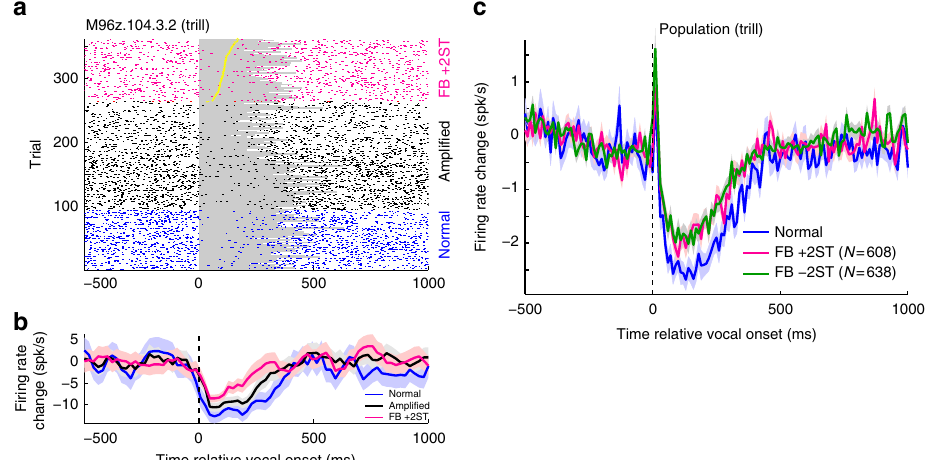
Fig. 2 Auditory cortical activity during shifted feedback. a Sample single-unit response raster and peri-stimulus time histogram (PSTH, b ) from an auditory cortex neuron suppressed by trill vocal production (vocal Response Modulation Index: RMI = − 0.53) but exhibiting decreased suppression during a + 2ST feedback shift (normal − 10.2 spk/s, ampli fi ed − 9.5, FB − 6.5; p < 0.001 Kruskal – Wallis; Error bars: SEM). Vocal intervals (shaded) and feedback onset times are indicated (yellow marker). c Population average PSTHs showing reduction in vocal suppression during shifted feedback compared to normal vocalizations for suppressed units (RMI < − 0.2). Indicated N is number of units. Sample sizes and statistical details may be found in the